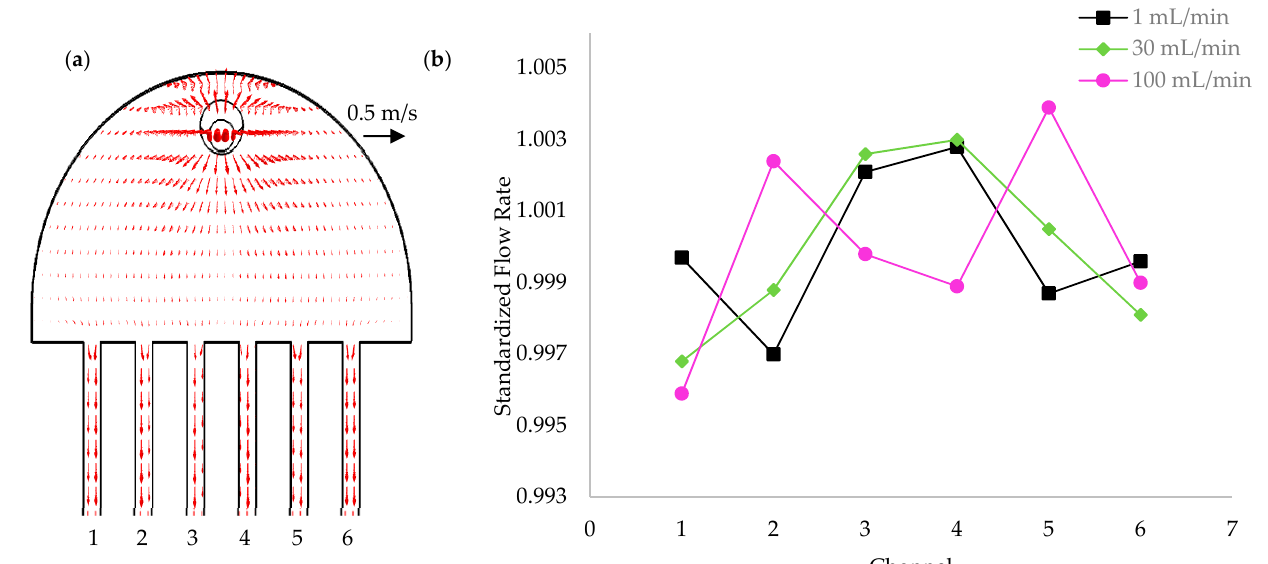
Figure 18. FDU study for the circular shape. ( a ) Schematic view of the velocity profile for a 100 mL/min flow and at a scale of 2. ( b ) Standardized flow in each channel of the heat sink.